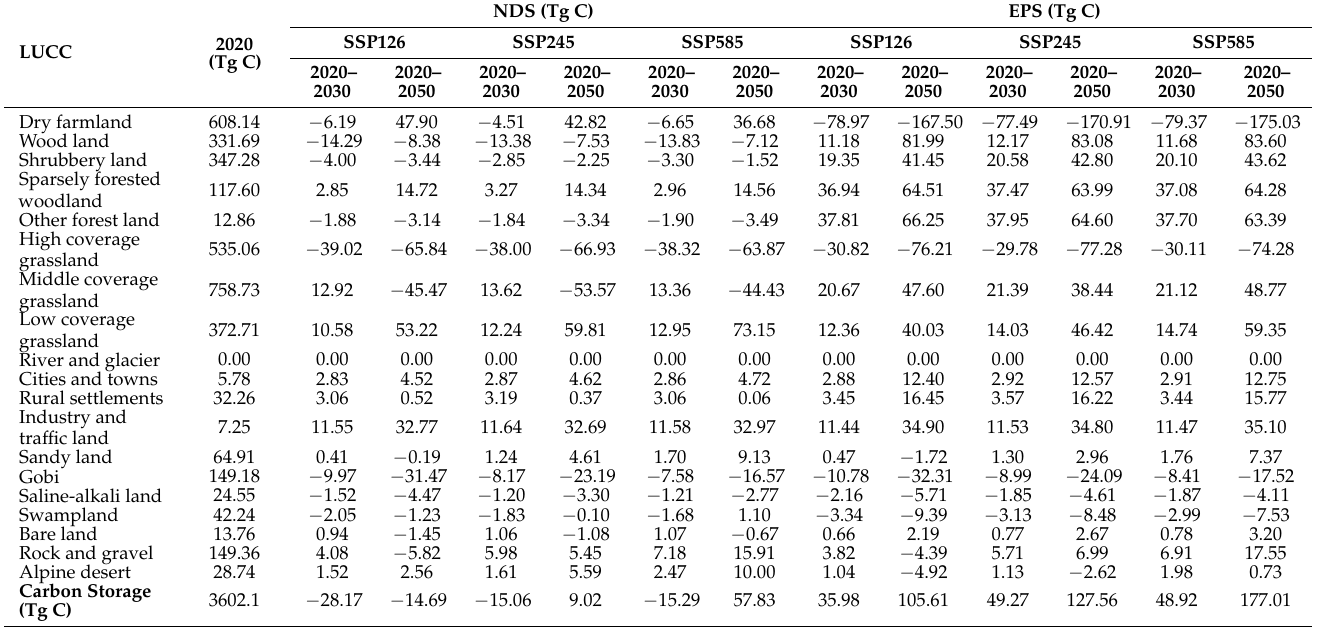
Table 6. Carbon storage changes in the Gansu province from 2020 to 2030 and from 2020 to 2050 under different LUTC Scenarios (NDS and EPS) and Future Climate Scenarios (SSP126, SSP245, and